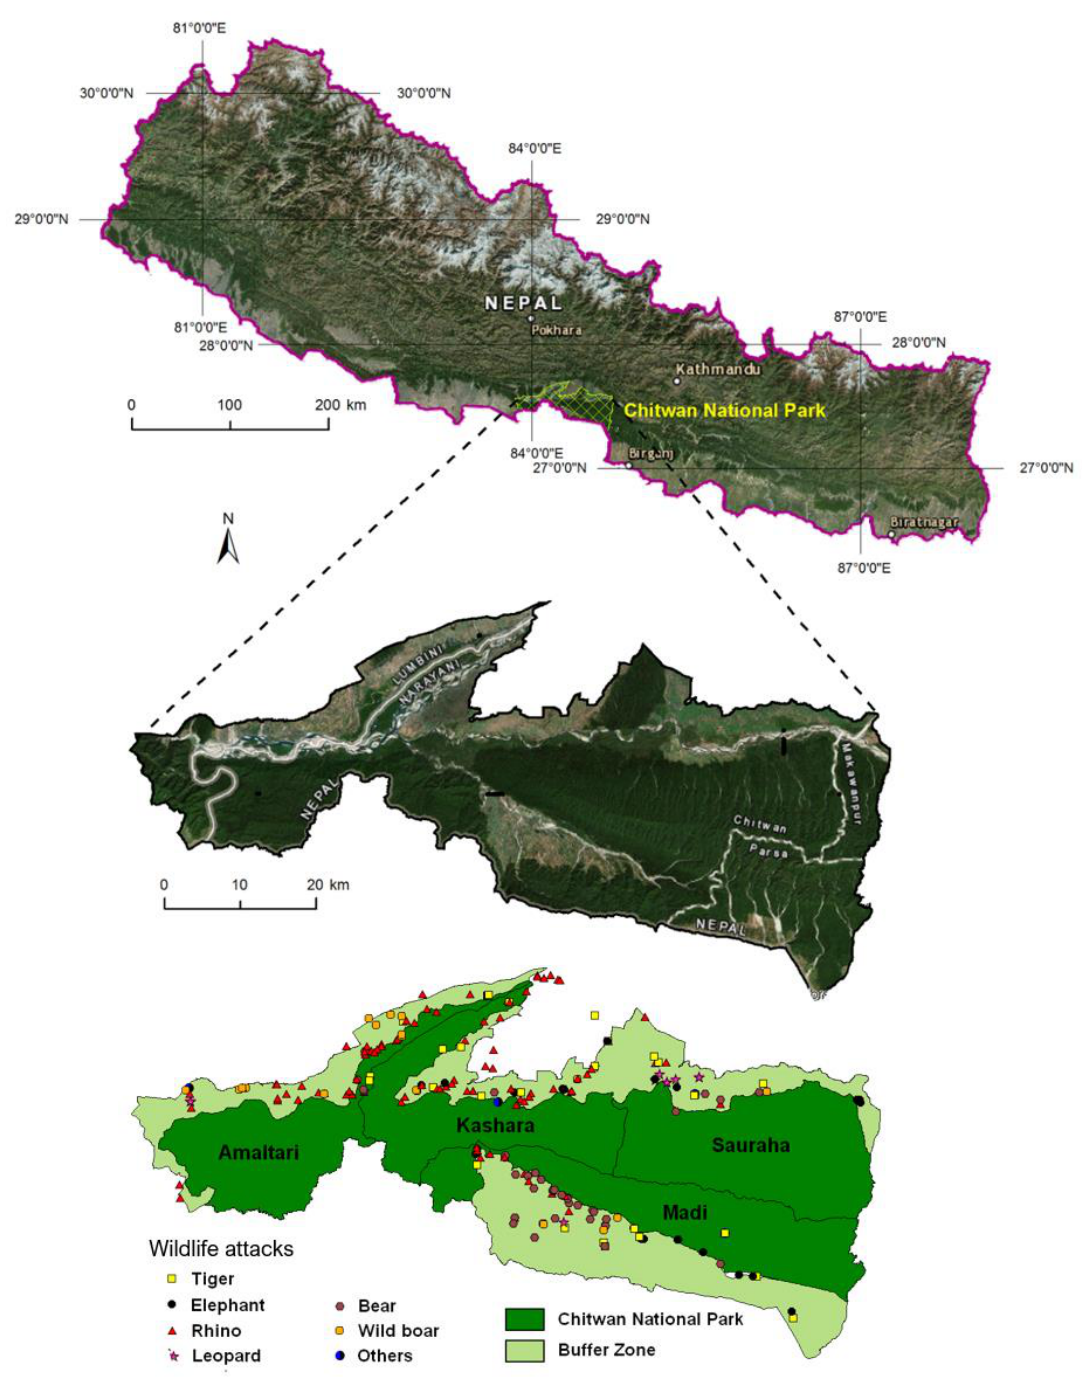
Figure 1. Location of Chitwan National Park on the Nepal–India border.